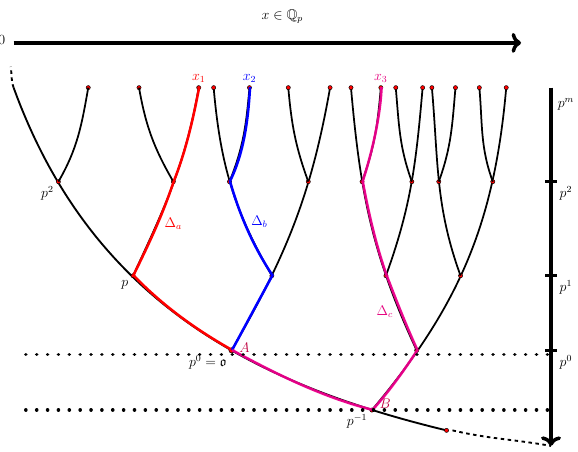
Figure 8. Computation of the 3-point function from the tensor